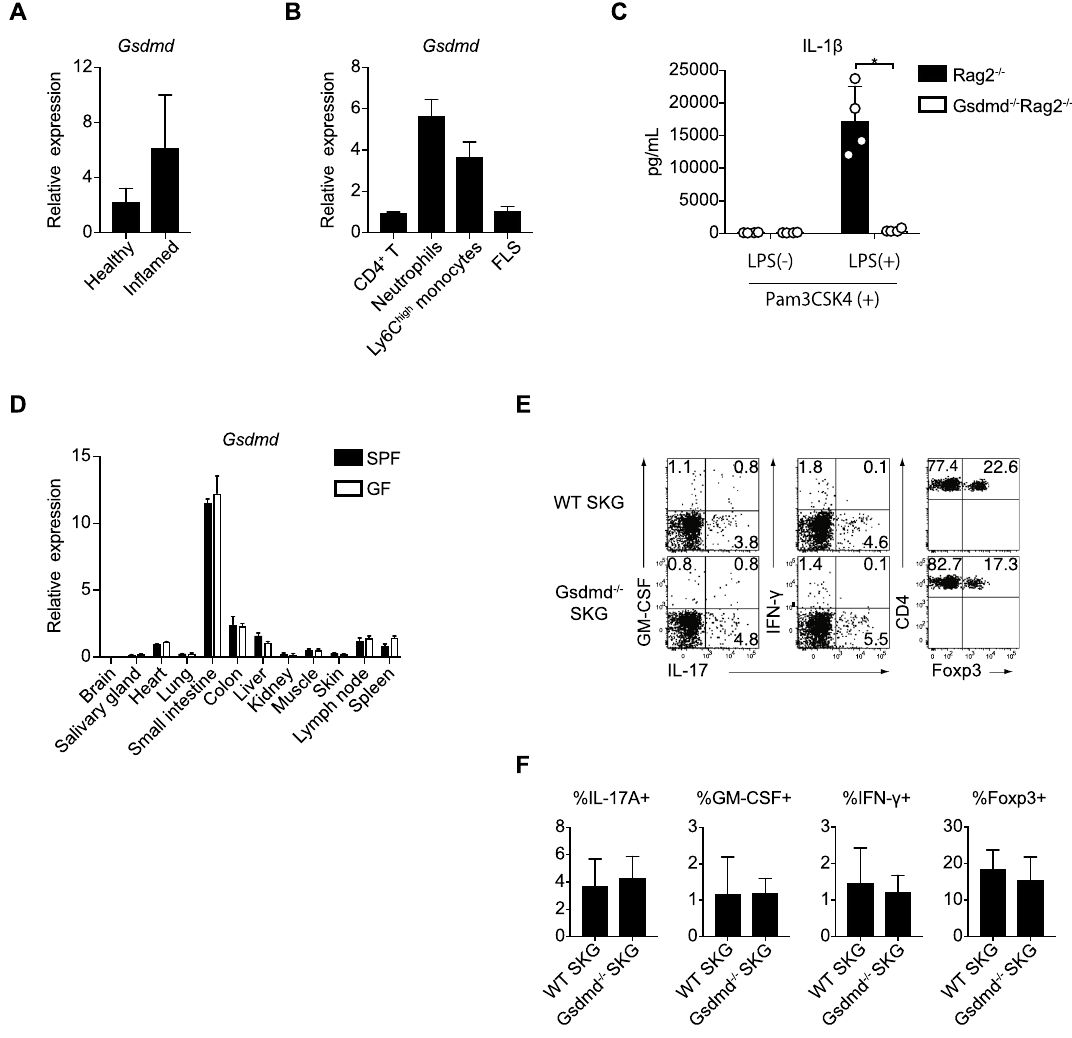
Figure 1. The Gsdmd expression in the tissues and inflammatory cells and CD4 + T cell profiles in Gsdmd -/- SKG mice. ( A ) Quantitative RT-PCR to analyze the expression of Gsdmd in whole synovial tissues of healthy and inflamed joints (n = 4 each). ( B ) Quantitative RT-PCR to detect the Gsdmd mRNA expression in CD4 + T cells, CD11b + Ly6G + neutrophils, CD11b + Ly6G - Ly6C high inflammatory monocytes and CD45 - CD31 - Podoplanin + FLS in inflamed joints (n = 4 each). ( C ) The IL-1β concentration of culture supernatant of Pam3CSK4-primed BMDCs at 16 h after LPS transfection (n = 4 each). ( D ) Quantitative RT-PCR to detect the expression of Gsdmd in the indicated organs of BALB/c mice housed under SPF or germ-free conditions (n = 4 each). ( E , F ) Flow cytometry of IL-17A + , GM-CSF + , IFN-γ + and Foxp3 + cells in CD4 + T cells in Peyer’s patches of age-matched healthy WT and Gsdmd −/− SKG mice (n = 8 each). The vertical bars denote the SD in panel (A–C,F) and SEM in panel (D) . * P < 0.05. Data are pooled from two independent experiments in panels ( A–D) and three independent experiments in panel (F)